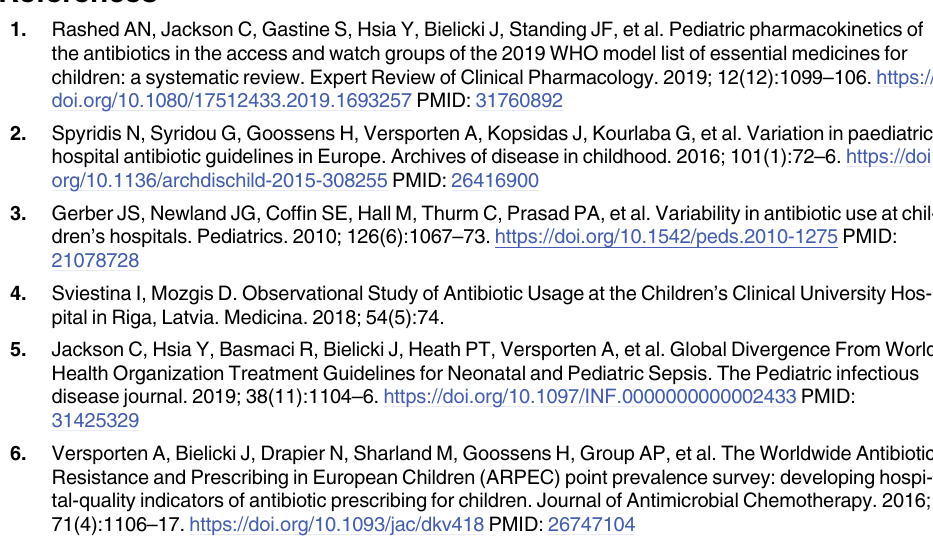
S7 Table. Fixed effects estimates from models of RDD. Models were run separately for each antibiotic and contained the same fixed and random effects for each model. Random effects were country and hospital within country. S8 Table. Variance components estimates from models of RDD. Models were run separately for each antibiotic and contained the same fixed and random effects for each model. Random effects were country and hospital within